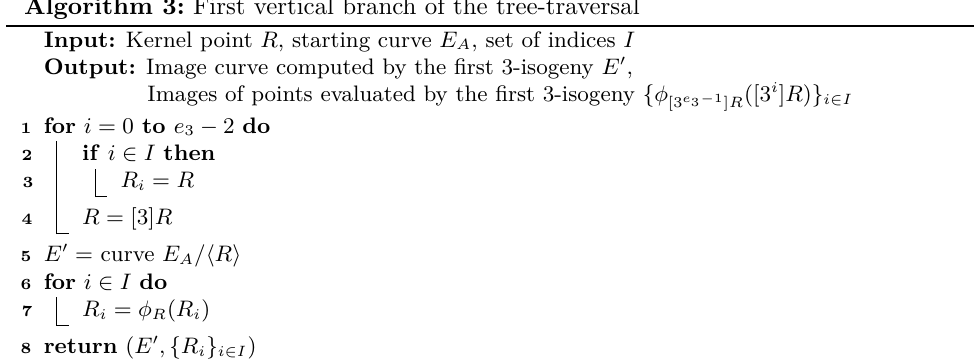
Algorithm 3: First vertical branch of the